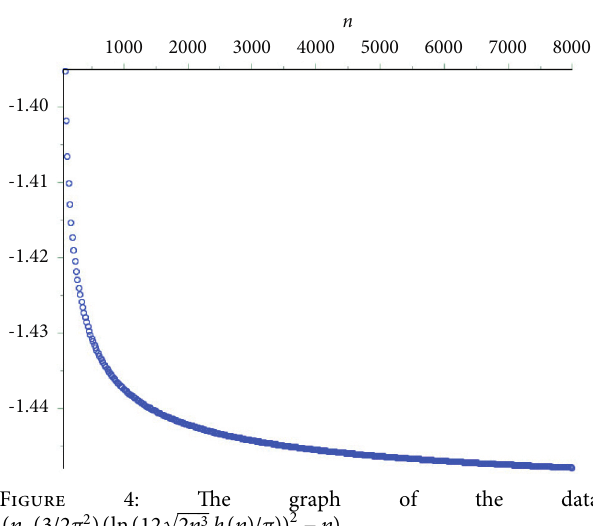
√ ��� h ( n ) / π )) 2 − n ) 2 n 3